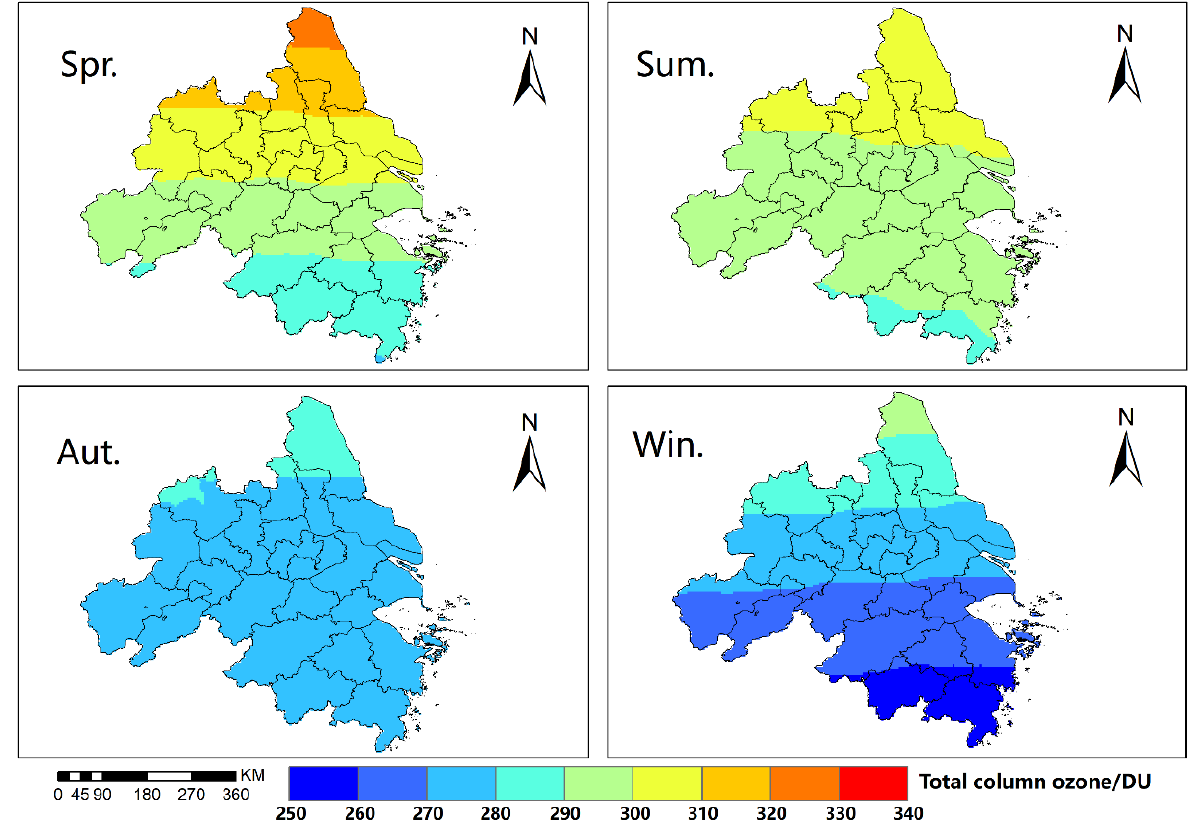
Figure 3. The seasonal variation distribution of the TCO over the Yangtze River Delta Urban Agglomerations during 2000–2019. These results were calculated by averaging the monthly data in spring (Spr., the months from March to May in a year) during 2000–2019, and the same progressed for summer (Sum., the months from June to August in a year), autumn (Aut., the months from September to November in a year), and winter (Win., the months from December to February in a year).